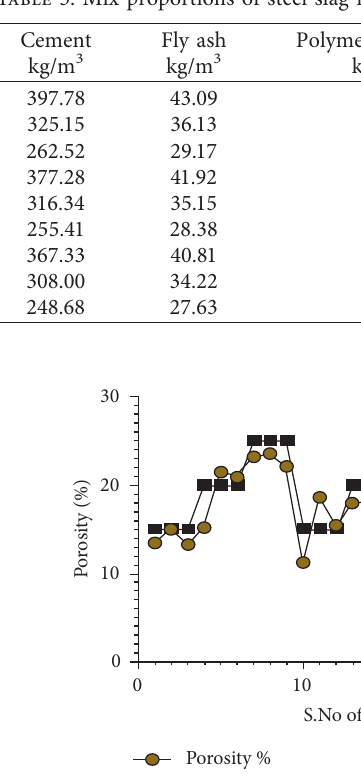
Table 5: Mix proportions of steel slag modified pervious concrete (in kg/m 3 ).